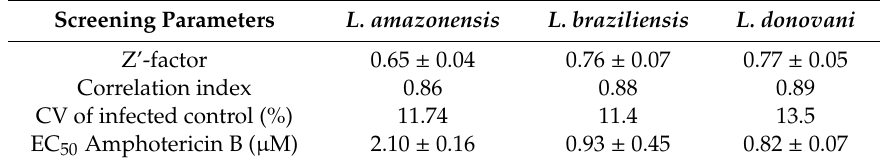
Table 1. Quantitative parameters of Leishmania multi-species high content screening. Screening